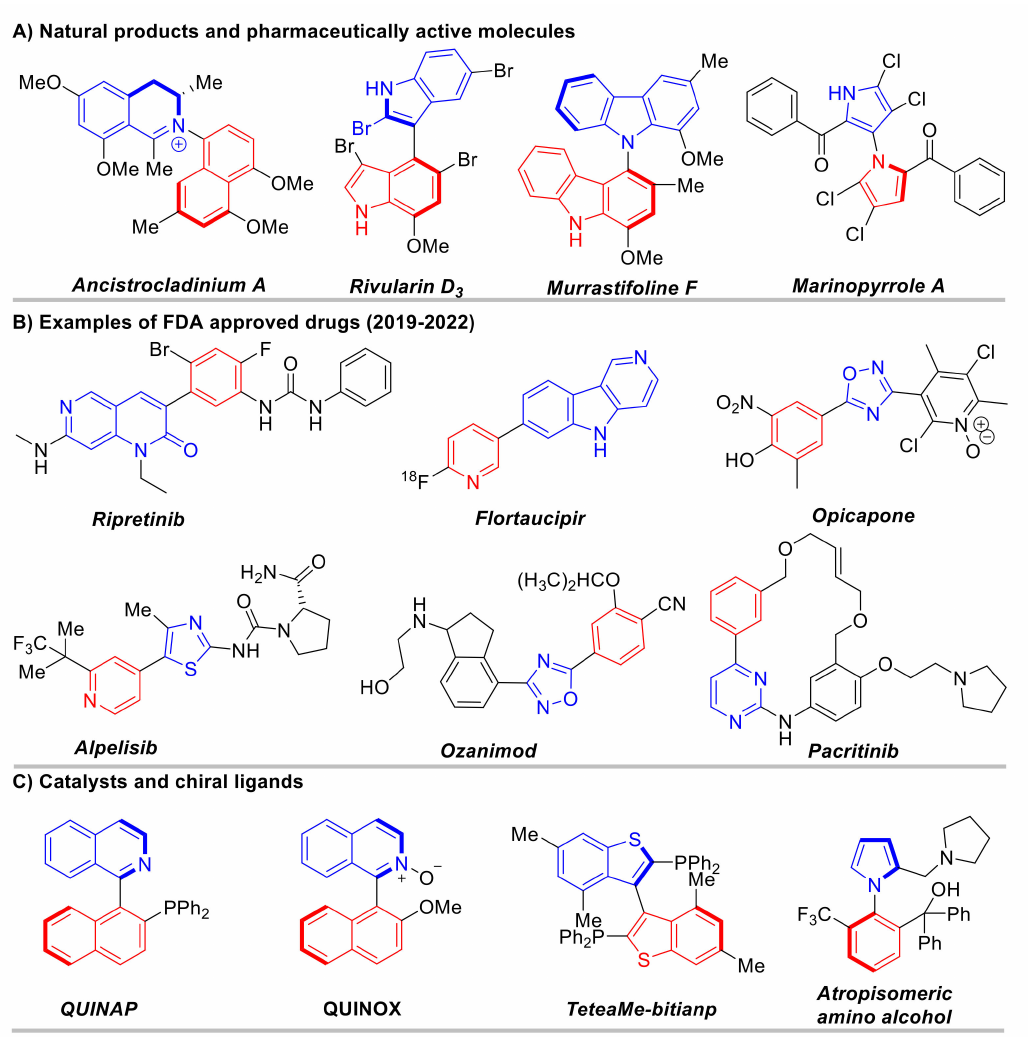
Figure 1. Representative heterobiaryl scaffolds in natural products, drug molecules, catalysts, and chiral